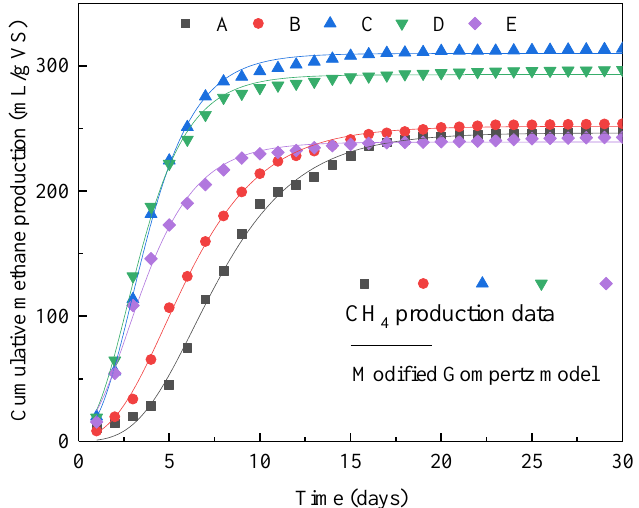
Figure 3. The fitting of the Gompertz model to the cumulative methane production curve of the experimental groups (the mixing ratios of kitchen waste and blackwater based on TS content in groups A–E are 4:0, 3:1, 1:1, 1:3, and 0:4, respectively). Table 5. Kinetic parameters of the modified Gompertz equation for methane production.